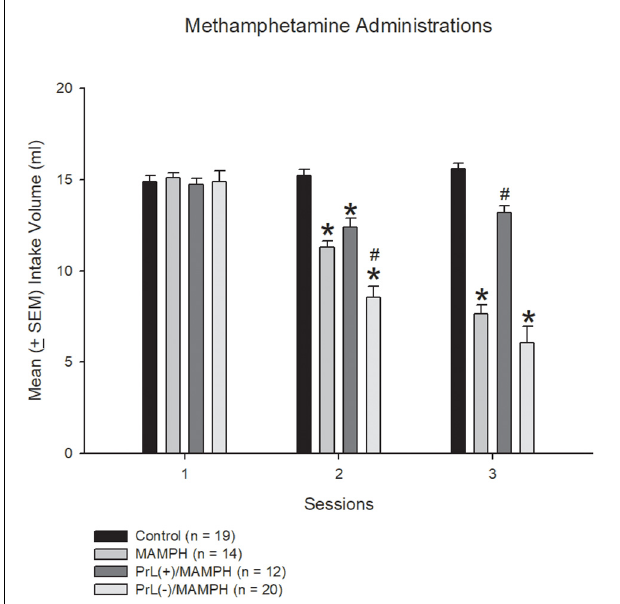
FIGURE 2 | MAMPH-induced conditioned taste aversion tested for behavior using NMDA or saline injections. Mean ( ± SEM) intake volume of 0.1% saccharin solution for three sessions (with 1 mg/kg of intraperitoneally injected MAMPH) across the control ( n = 19), MAMPH ( n = 14), PrL (+)/MAMPH ( n = 12), and PrL(–)/MAMPH groups ( n = 20). PrL(+): Injection of a low concentration of NMDA to excite the PrL neurons; PrL(–): Injection of a high concentration of NMDA to destroy the PrL neurons. Differences in the intake volumes of 0.1% saccharin solution among all groups in each session were